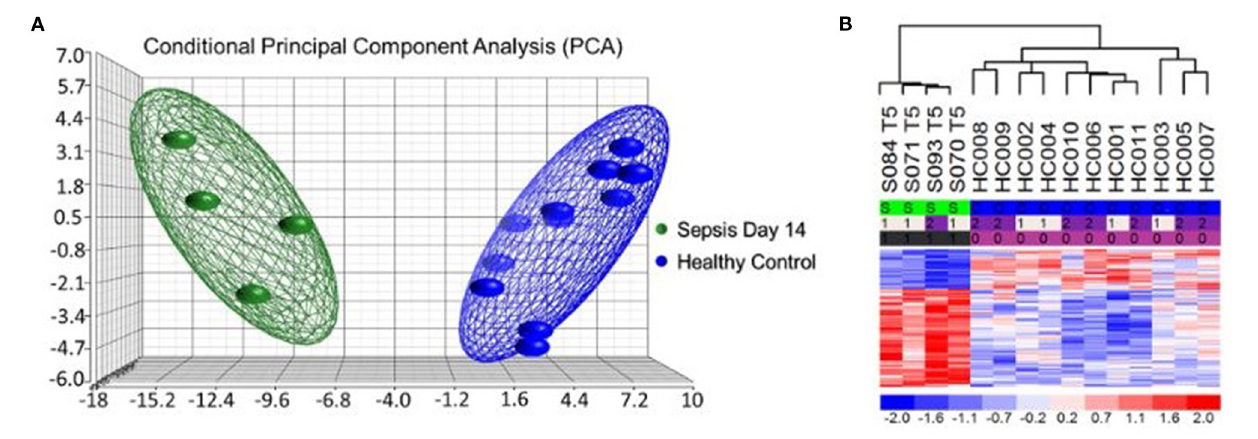
FIGURE 4 | Microarray Transcriptomic Analysis of MDSCs from Patients 14 days after Sepsis and Healthy Control Subjects. The genomic response of bulk isolated MDSC RNA in healthy controls and septic patients 14 days after initial infectious onset. (A) Conditional principal component analysis of septic (day 14) and healthy control MDSC gene expression patterns. (B) Heat map of the hierarchical clustering of MDSC gene expression patterns and variation between septic patients (S) from day 14 and healthy (H) control subjects. Modified from Mathias et al. (67).